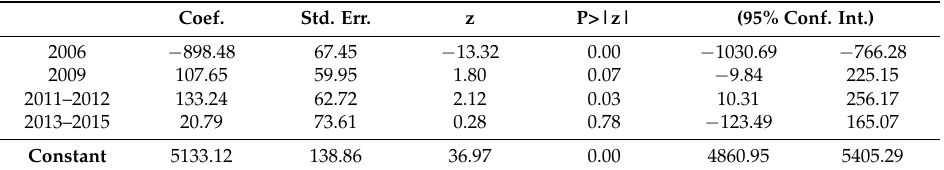
Table 6. Generalized Estimating Equations (GEE) estimation of trend in annual cigarette expenditure per smoker in China, 2006–2015. Coef.